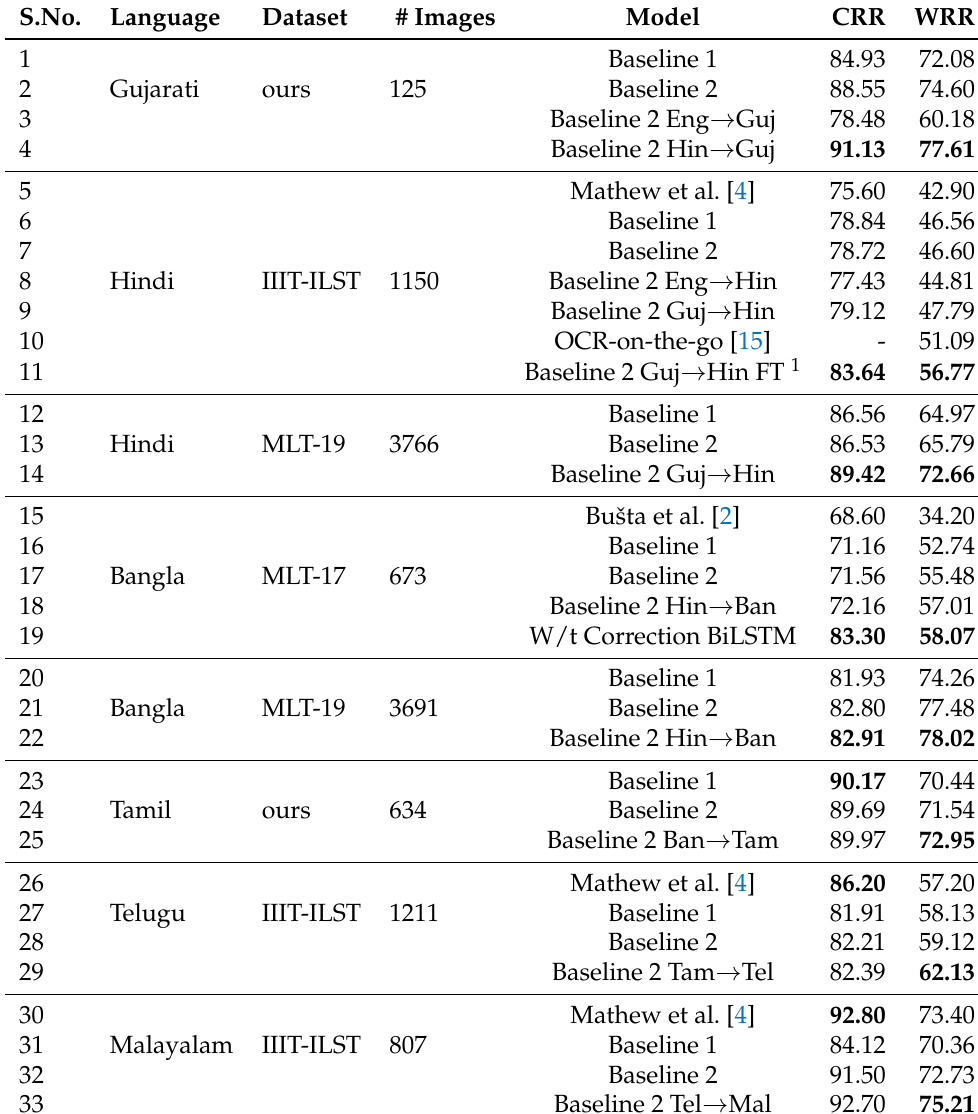
Table 4. Results on real datasets. FT indicates fine-tuned. For number of synthetic training samples and fonts, refer Table 2. # represent the number of